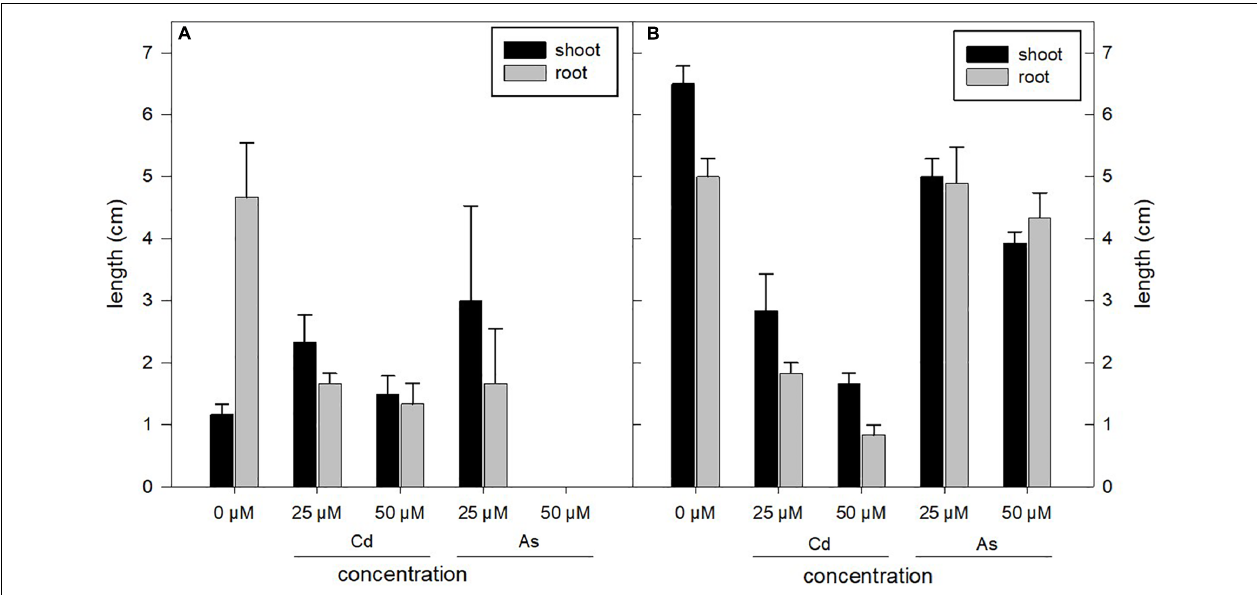
FIGURE 3 | Root and shoot lengths of sylvestris (A) and altilis (B) harvested after 21 days of treatment under different concentrations of As and Cd. The error bars indicate the standard deviation of three biological replicates.